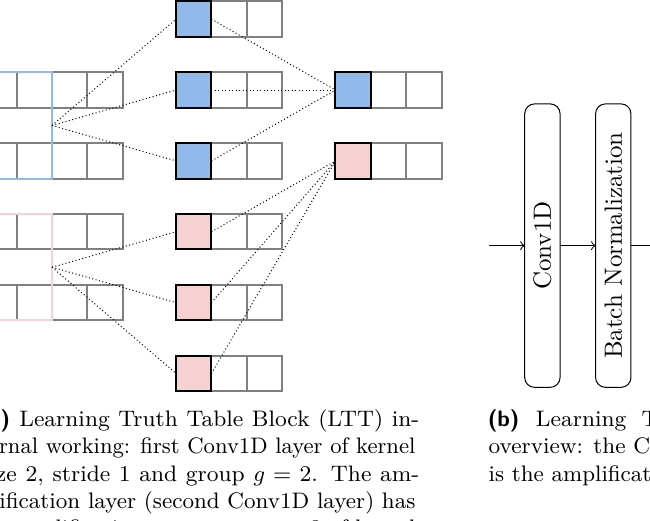
Figure 2: Learning Truth Table Block